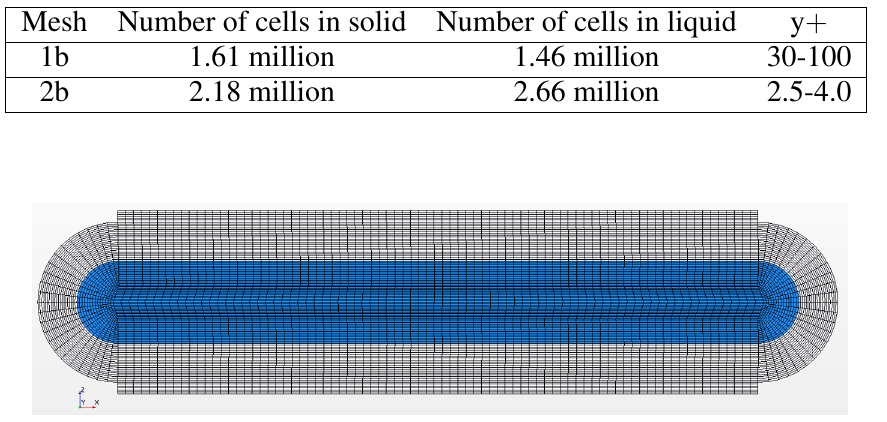
Figure 2: Mesh in the cross section of the STAR-CCM+ models with y+ > 30